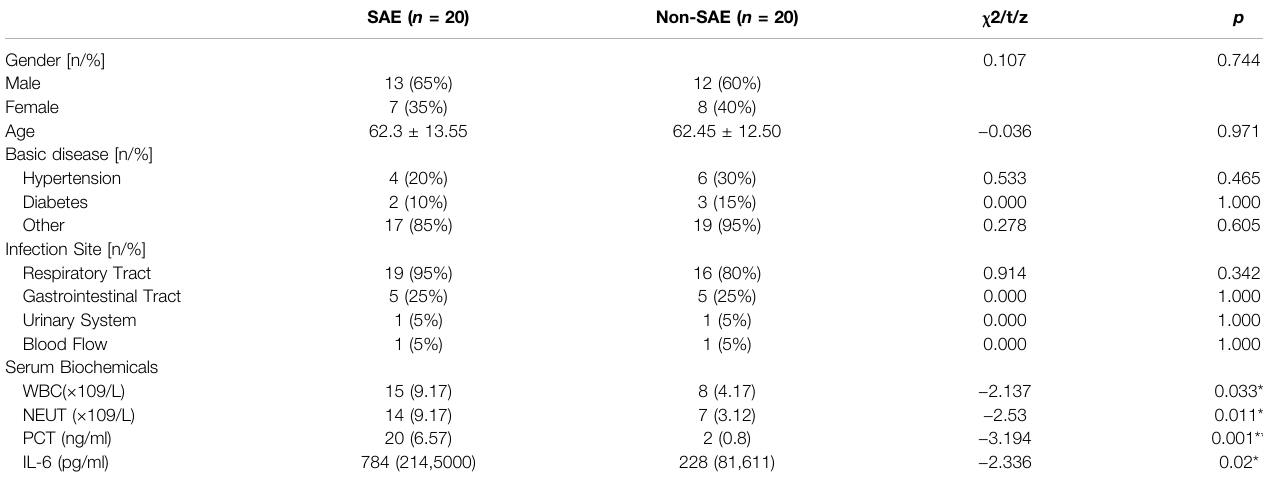
TABLE 1 | Analysis of general patient data.